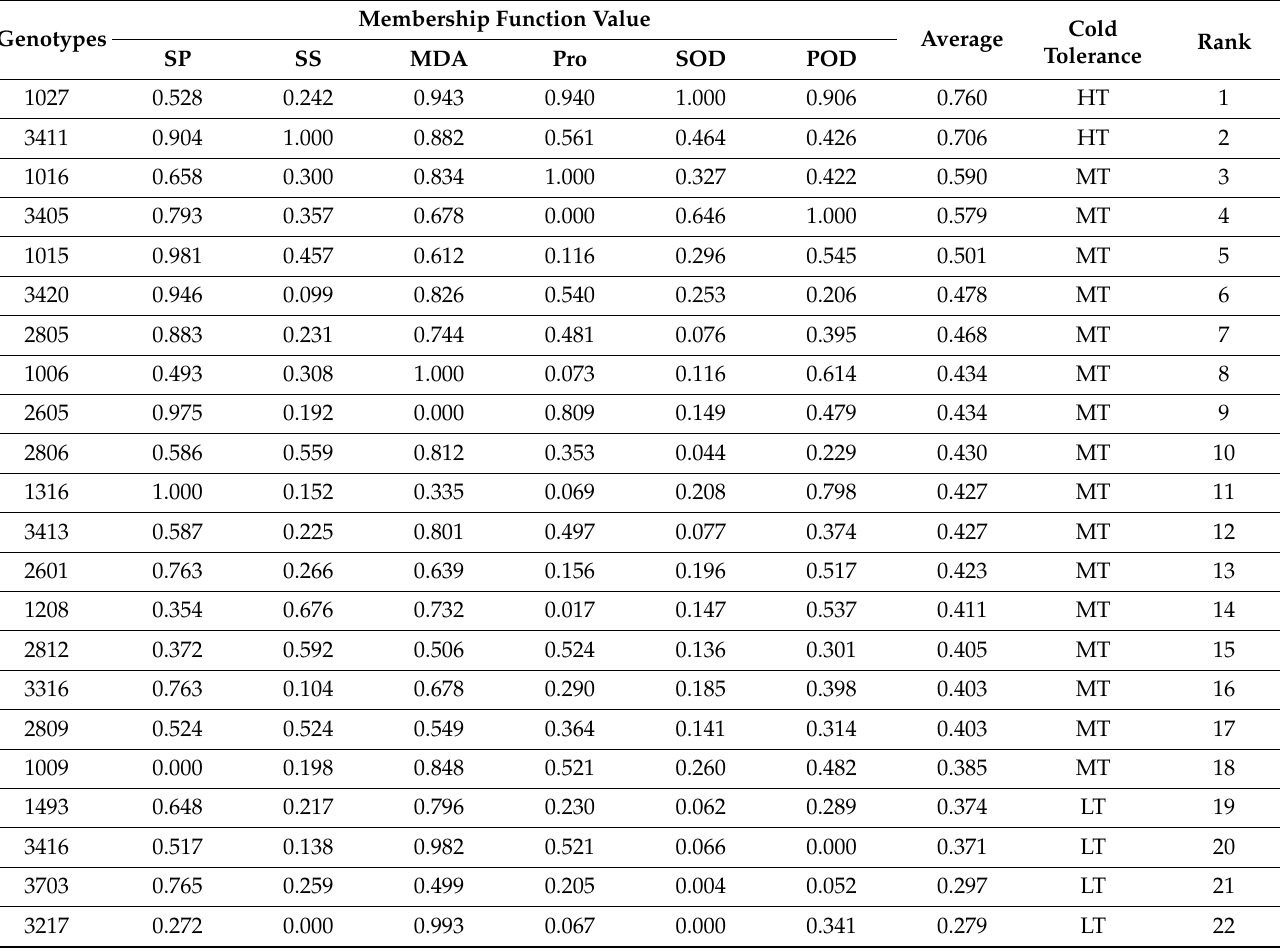
function values included SP, SS, MDA, Pro, SOD, and POD, and the results are shown in Table 1. According to the average membership function values, the cold tolerance ability of 22 S. spontaneum genotypes was divided into three levels: high tolerance (HT), medium tolerance (MT), and low tolerance (LT). Among the 22 genotypes, only two genotypes, 1027 and 3411, were classed as high-tolerance, while four genotypes were classed as low- tolerance, among which genotype 3217 had the weakest cold tolerance. According to these results, high-tolerance genotype 1027 (Figure 2a) and low-tolerance genotype 3217 (Figure 2b) were selected as the tested materials for proteomic analysis. Table 1. Cold tolerance classification of S. spontaneum according to membership function values based on physiological and biochemical